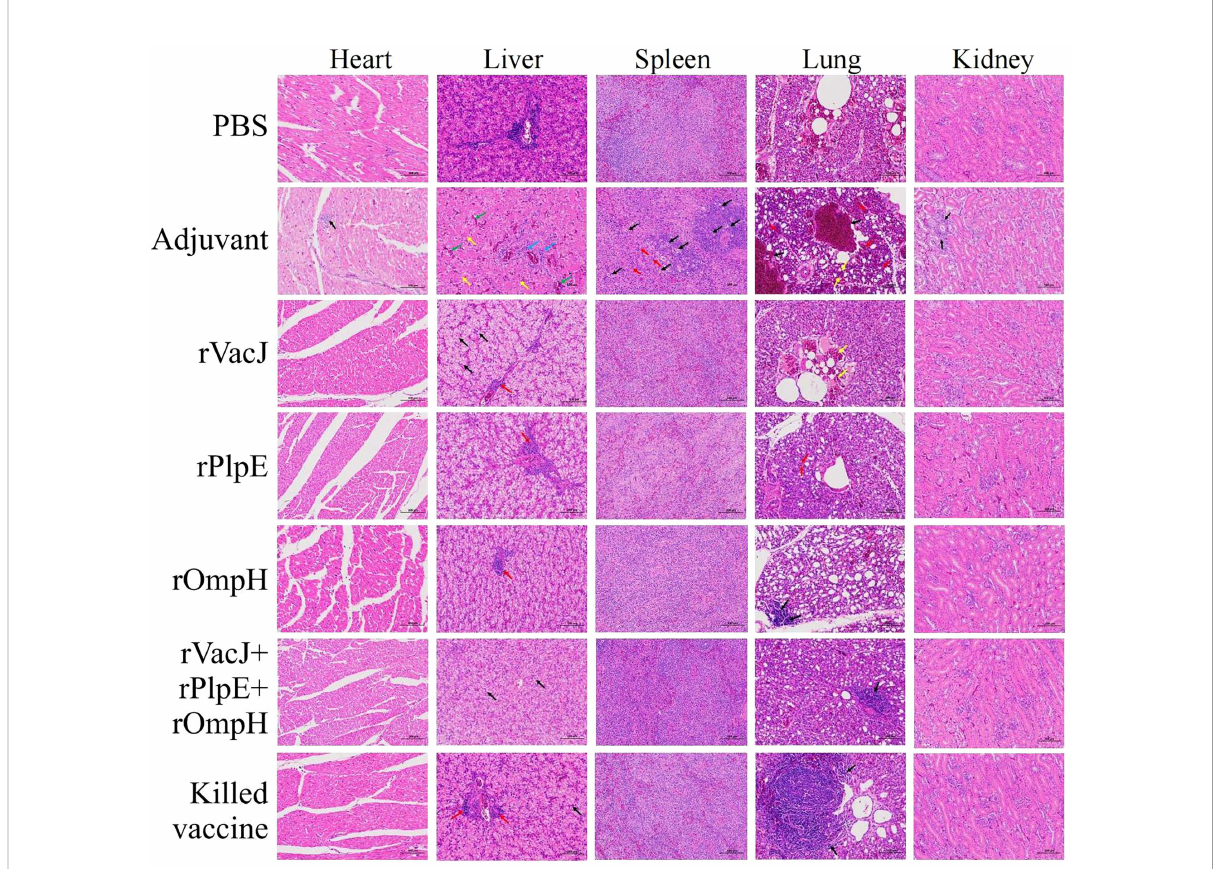
FIGURE 3 Ducks in Group 2-7 were challenged with 20-fold LD50 of the P. multocida PMWSG-4 strain intramuscularly 14 days after the booster. Then, histopathological lesions in the heart, liver, spleen, lung, and kidney (n=3/group) were analyzed by HE staining at 3 days post-challenge. The representative results of each group were